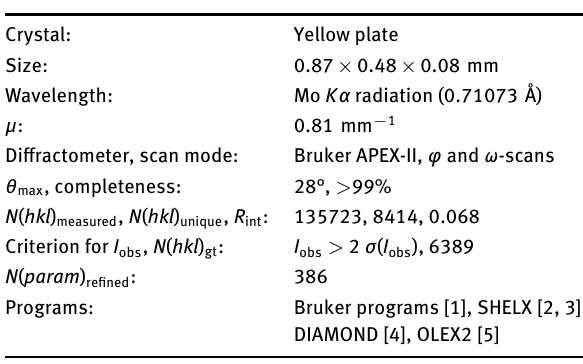
Table 1: Data collection and handling.